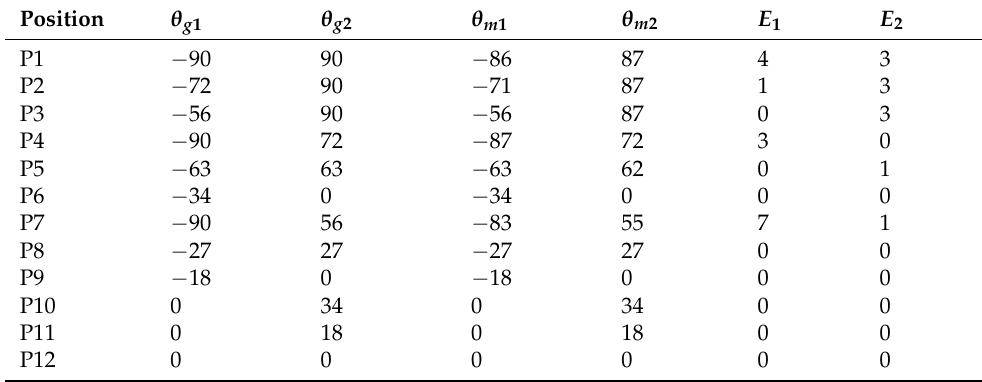
Table 7. Angle estimation results and error values found from Experiment B ( ◦ ).